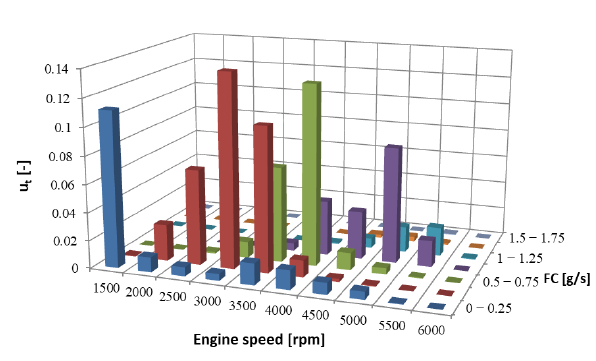
Fig. 7. Operating time density for different speed ranges and fuel con- sumption values